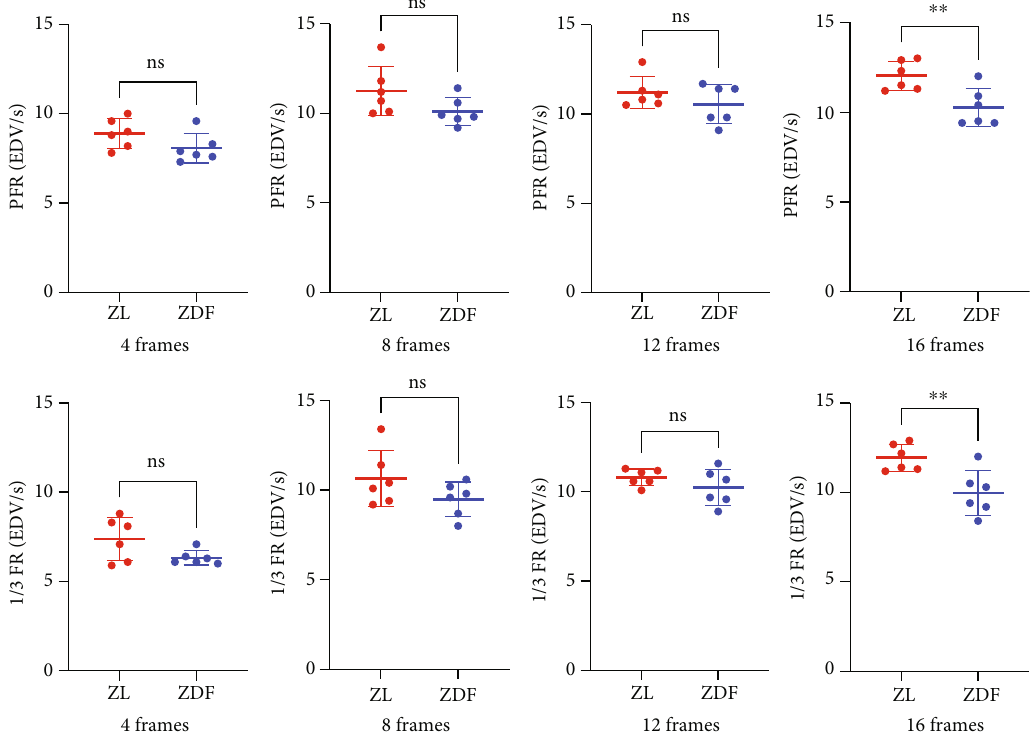
Figure 5: Impact of number of frames for diastolic parameters (PFR and 1/3 FR) between ZDF (diabetic rats) and ZL (control rats). For 16 frames per cardiac cycle, a signi fi cant di ff erence was noted for both parameters ( ∗∗ P < 0 : 005 , far right), but not for 4, 8, and 12 frames per